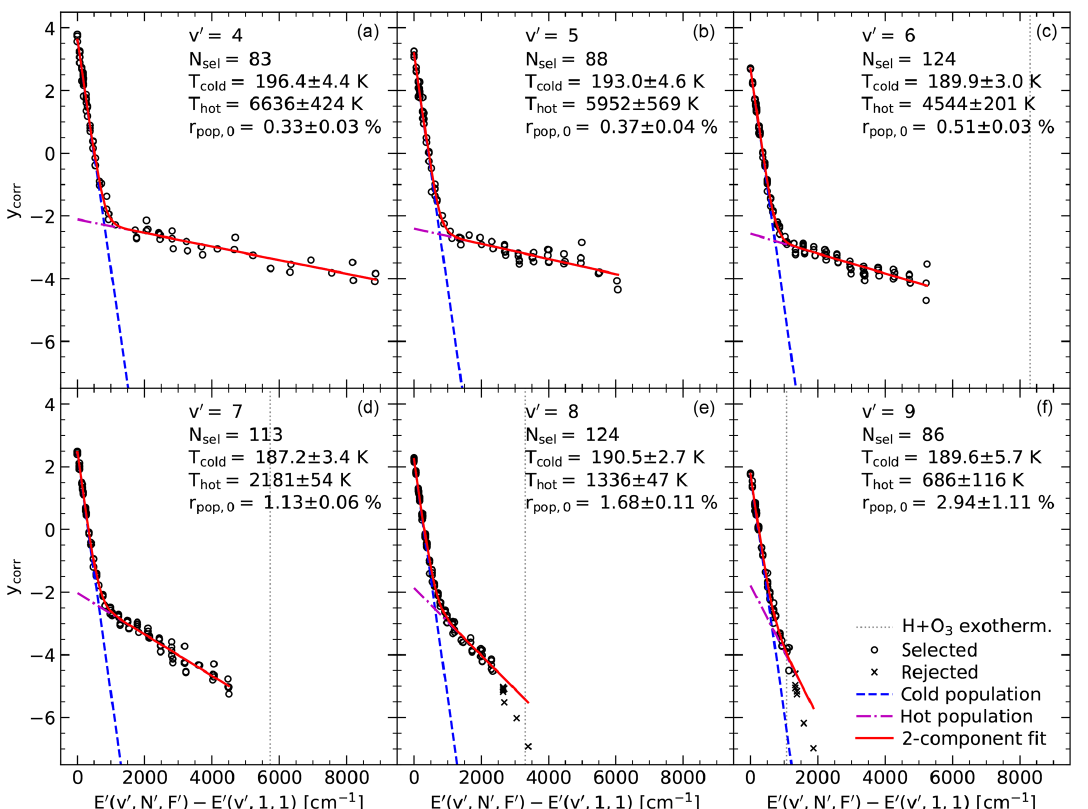
Figure 12. Distribution of logarithmic OH level populations for the corrected Brooke et al. (2016) Einstein- A coefficients. Except for OH(7-1), all (cid:51) doublets with at least one reliable component are considered. The populations are plotted in separate panels for each up- per vibrational level v (cid:48) between 4 and 9. The given level energies in inverse centimetres are relative to the lowest v (cid:48) -related energy. The populations can be fitted by means of a two-component rotational temperature fit. All data points involved are marked by circles. The few exceptions (indicated by crosses) are close to or above the exothermicity limit of the hydrogen–ozone reaction, which is marked by vertical dotted lines. For these data, a more complex fit would be necessary. The final fit curves are displayed by solid lines. The underlying cold and hot components are shown by dashed and dot-dashed lines, respectively. Each panel lists the v (cid:48) -specific number of selected data points N sel , the rotational temperatures of the cold and hot components T cold and T hot in kelvins, and the ratio r pop , 0 of the populations of both linear fit components for the lowest v (cid:48) -related energy in per